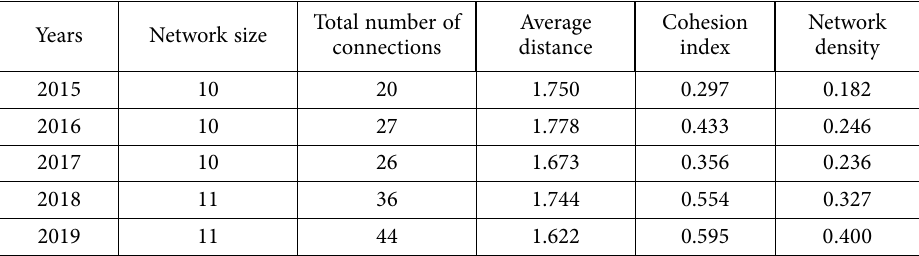
Figure 1. The green development spatial association network in the GBA in 2015 and 2019 Table 4. Structural characteristics of the GBA’s green development spatial association